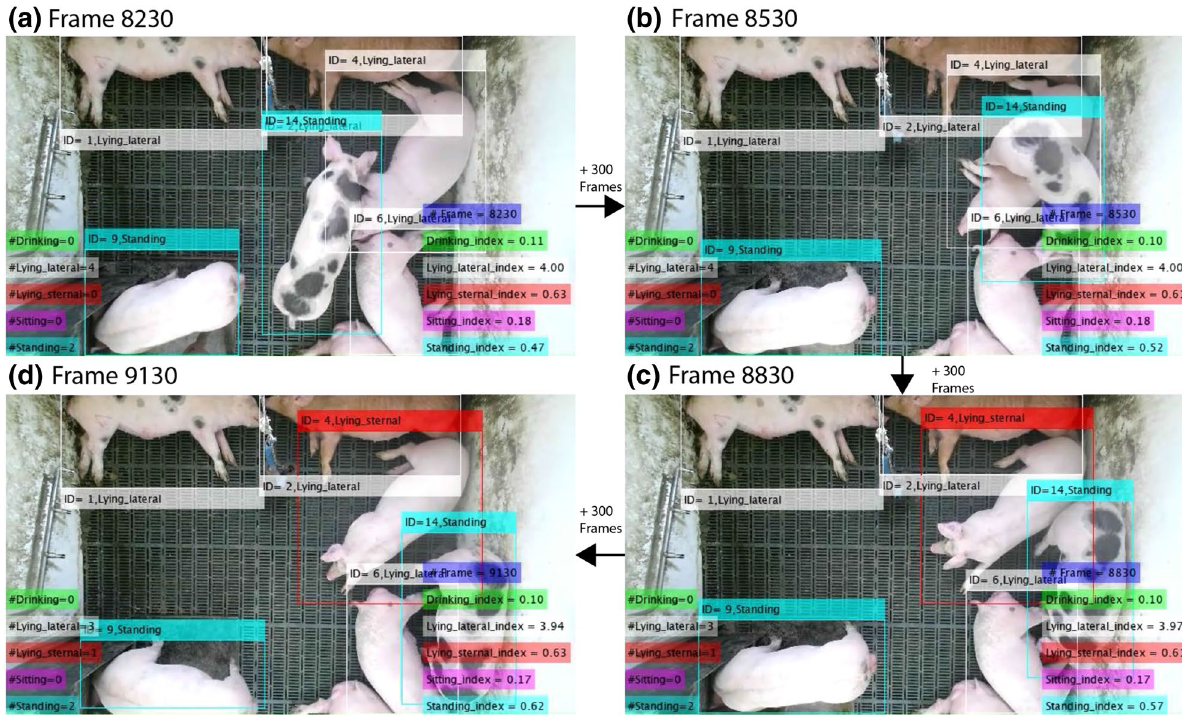
Figure 5. Example of detecting pig postures across a period of 900 consecutive frames, with an interval of 300, using our primary model. The proposed model generated indices to each pig behaviour; it also assigned a vID to each pig to associate these across frames. The images in the figure were extracted from our dataset (‘Methods’